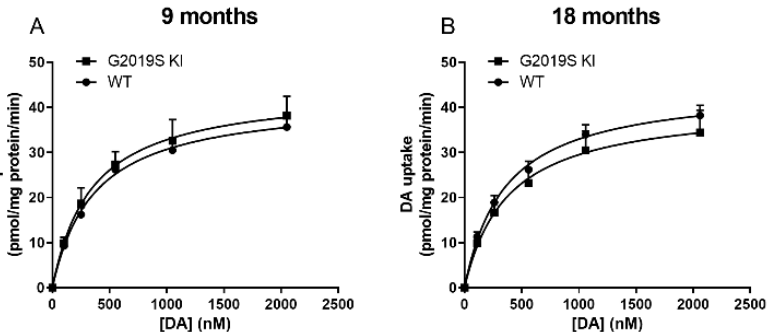
Figure 5. VMAT2 activity is unaltered in 9 and 18-month-old G2019S KI mice. Kinetic analysis of [ 3 H]-DA uptake in whole-brain vesicles in the striatum of 9-month-old ( A ) and 18-month-old ( B ) G2019S KI mice versus age-matched WT controls. Data are expressed as mean ± SEM of n = 4 animals per group.